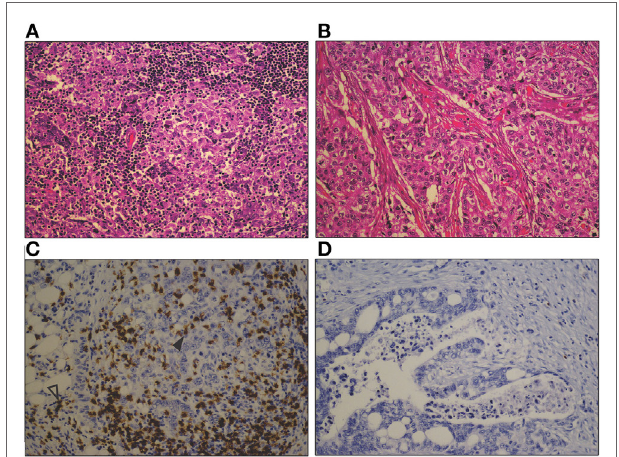
FigURe 1 | Photomicrographs comparing a heavy lymphocytic infiltrate in a basal phenotype breast carcinoma (A), with a sparse infiltrate in a different basal phenotype breast carcinoma (B) (H&e, original magnification 200 × ) . A similar contrast is seen between a marked CD8 + T cell infiltrate in a mismatch repair-deficient colon cancer (C) , and the sparse infiltrate in a mismatch repair proficient colon cancer (D) . CD8 + T cells are seen both within the tumor epithelium (closed arrowhead) and in the tumor stroma (open arrowhead) (CD8 immunohistochemical stain, original magnification 200 ×